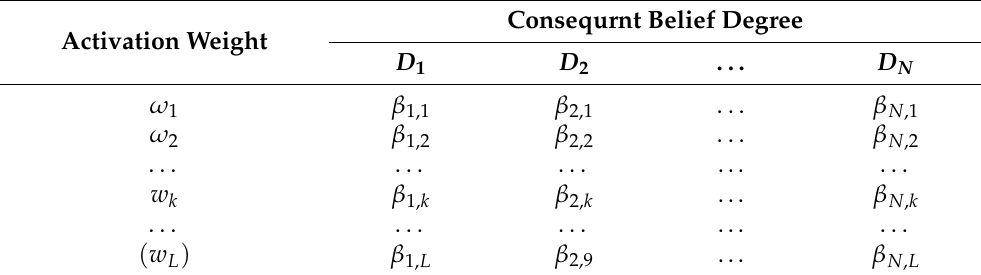
Table 2. A belief rule expression matrix summarizing the information of the belief rule base with L belief rules and N consequent referential